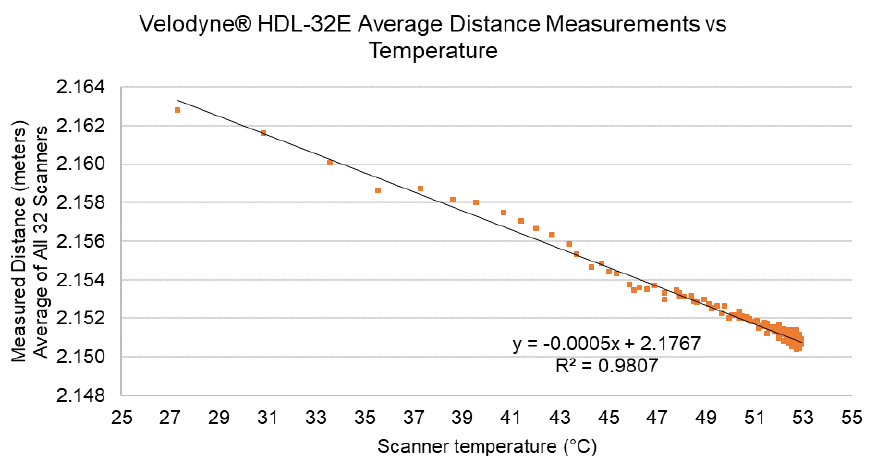
Figure 17. Linear relationship and correlation between Velodyne ® HDL–32E internal temperature and overall average measured distance through the duration of indoor experiments. Equation for linear line of best fit and corresponding R 2 values are shown on the